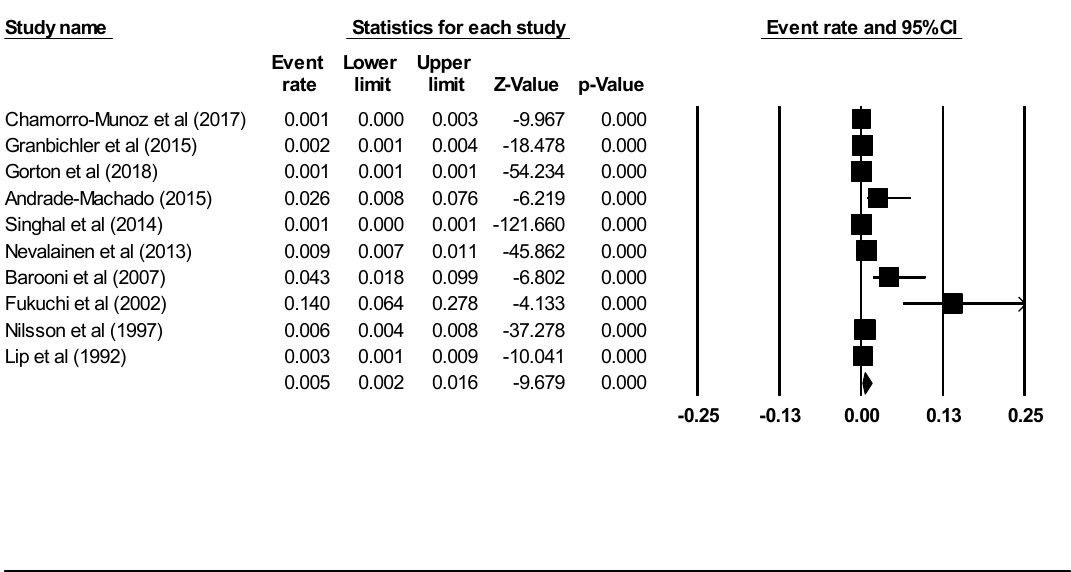
Figure 4. Forest plot of pooled rate of death by suicide among PWE.